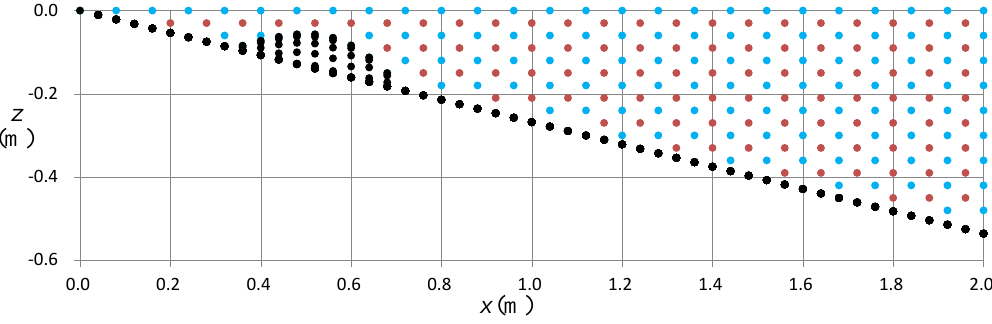
Figure 5. Illustration of the arrangement of the collocation points. Blue points are on the cross sections of y =0, y = 0.008043 m, y = 0.016086 m, …, y = 1.85 m. Red points are on the cross sections of of y =0, y = 0.008043 m, y = 0.016086 m, . . . , y = 1.85 m. Red points are on the cross sections of y = 0.004022 m, y = 0.012065 m, …, y = 1.845978 m. Black points are on the bottom. y = 0.004022 m, y = 0.012065 m, . . . , y = 1.845978 m. Black points are on the